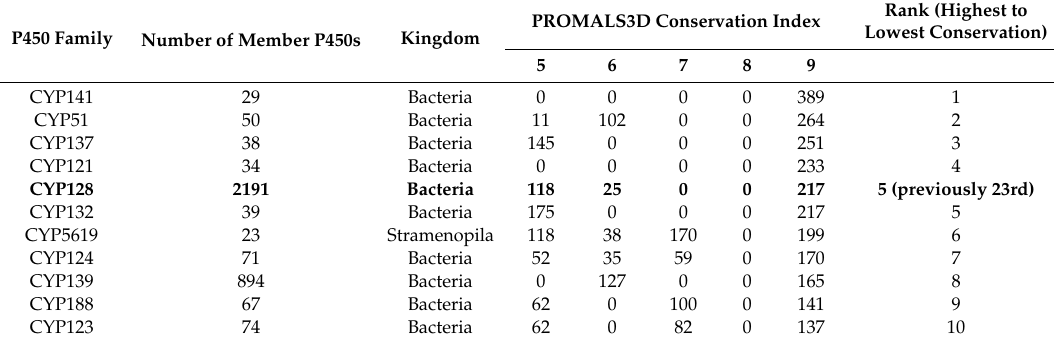
Table 1. Comparative amino acid conservation analysis of CYP128 P450 family with top 10 ranked families. The conservation index score (5–9) is obtained as described elsewhere [33] using PROMALS3D, where the number 9 indicates invariantly conserved amino acids in P450 members. The CYP128 family is indicated in